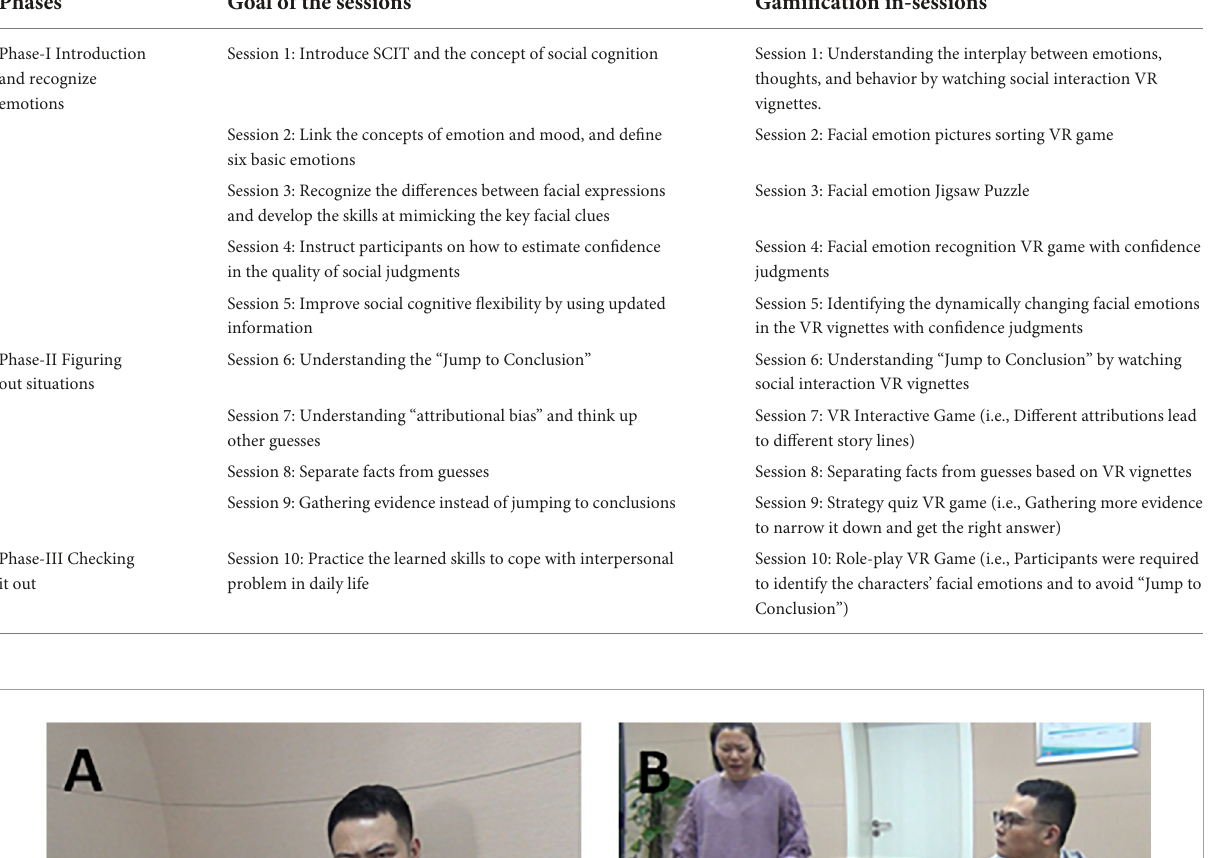
TABLE 1 The details of VR-based social cognition and interaction training (VR-SCIT) sessions.